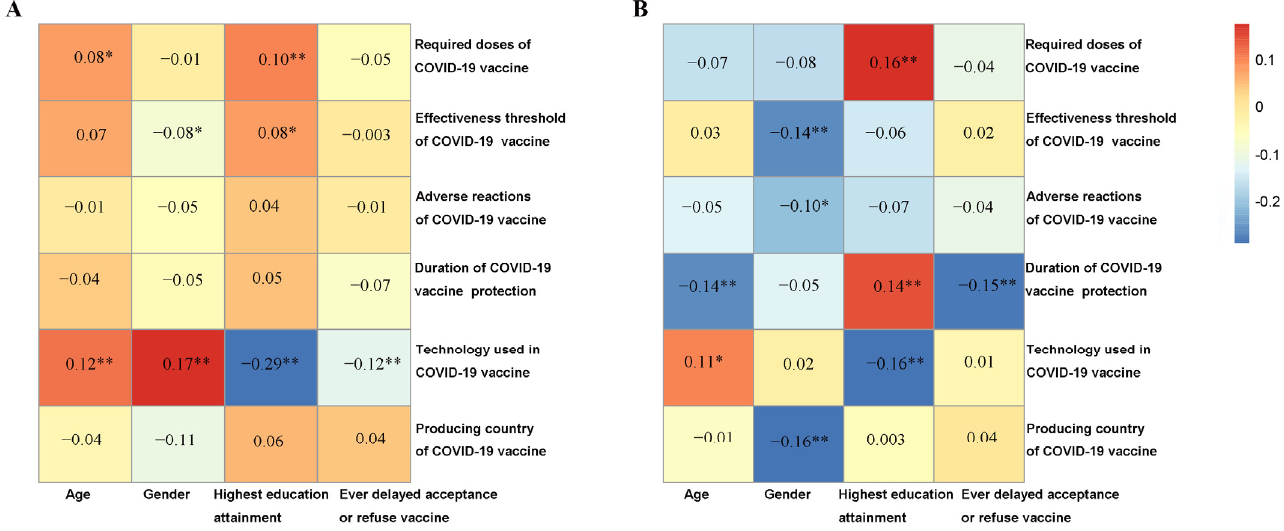
Figure 4. The correlations between demographic characteristics and vaccine characteristics influencing vaccination attitudes of participants in Japan. ( A ) In extremely likely/likely participants and ( B ) in extremely unlikely/unlikely participants. * p < 0.05, ** p < 0.01.